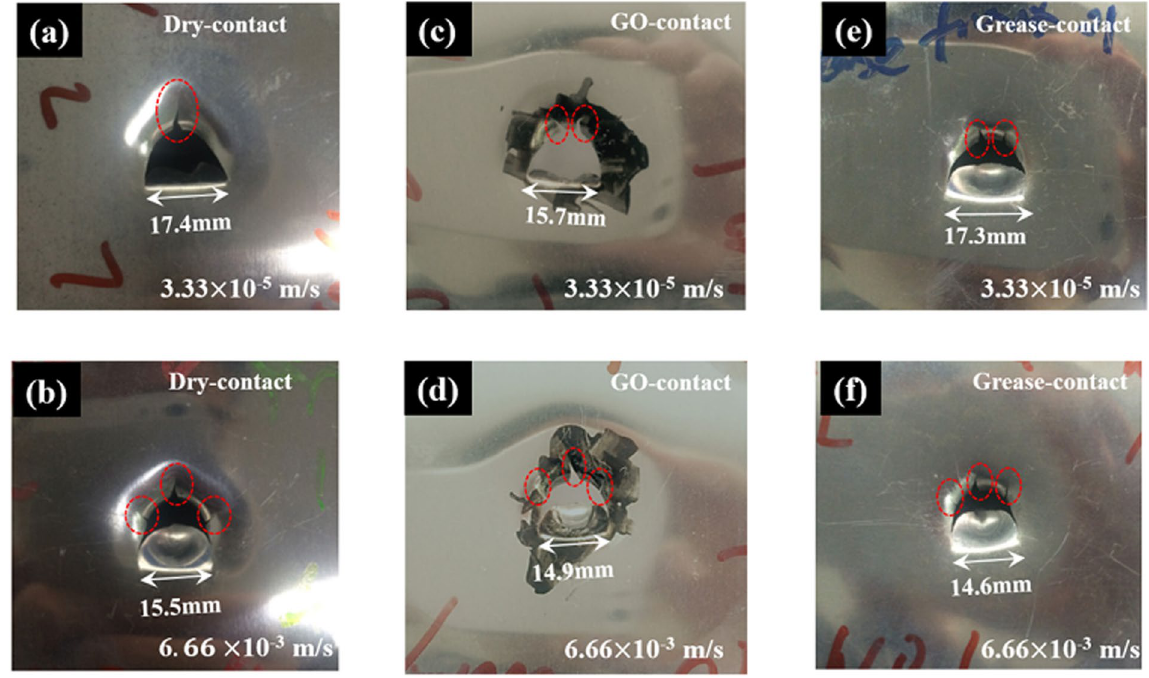
Figure 5. Macroscopic morphology of single-layer aluminium sheet after puncture tests: ( a ) dry-contact code under 3.33 × 10 − 5 m/s loading, ( b ) dry-contact code under 6.66 × 10 − 3 m/s loading; ( c ) GO-contact code under 3.33 × 10 − 5 m/s loading, ( d ) GO-contact code under 6.66 × 10 − 3 m/s loading; ( e ) grease-contact code under 3.33 × 10 − 5 m/s loading, ( f ) grease-contact code under 6.66 × 10 − 3 m/s